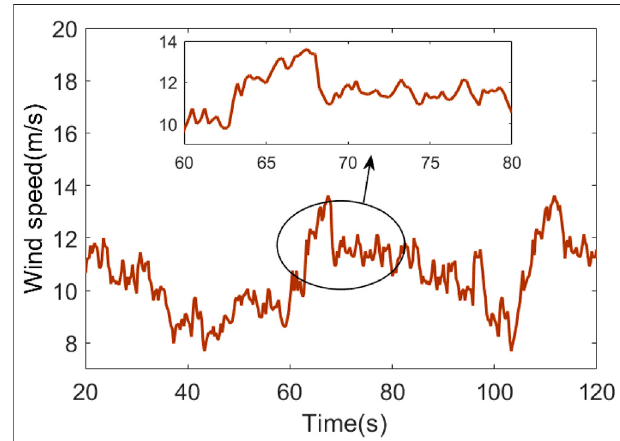
FIGURE 10 | Comparison curves of pitch angle under gust wind.